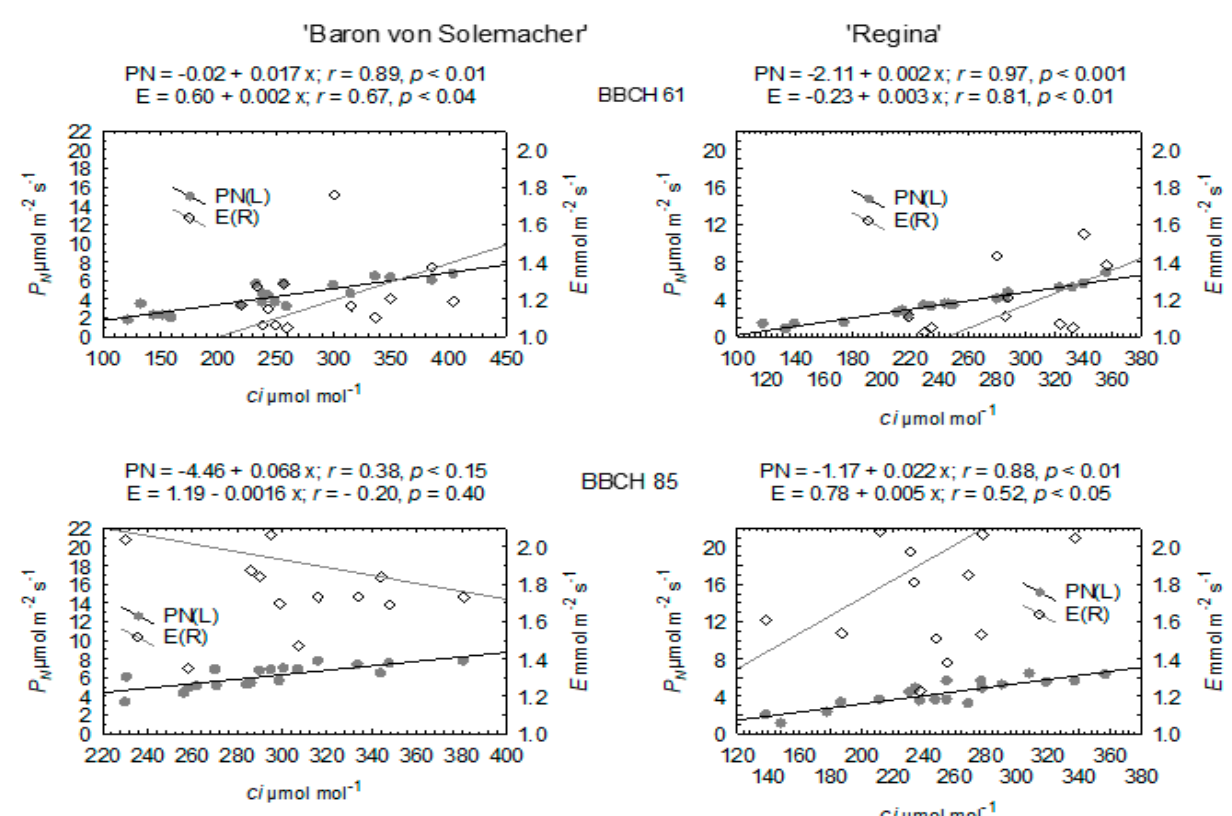
Figure 4. The relationships are based on r -Pearson’s correlation coefficient and linear regressions between the concentration of intercellular CO 2 ( Ci ) vs. photosynthetic rate ( P N ) and transpiration ( E ) parameters at two growing stages of wild strawberry.